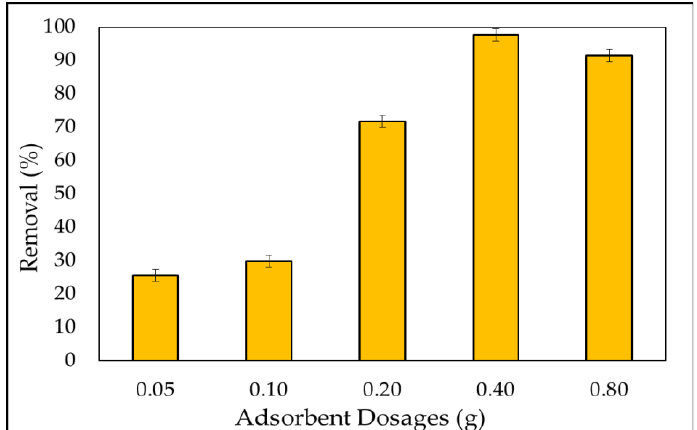
Figure 7. Effect of A. platensis nanoparticles adsorbent dosages on the removal of MBD (varying dosage of A. platensis nanoparticles from 0.05 to 0.8 g at a dye initial concentration of 5 mg L −1 ; pH value 6; contact time 180 min; initial volume: 50 mL; and 180 rpm).